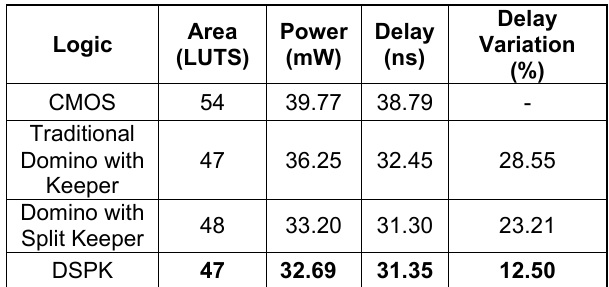
Table 7. Circuit Analysed: